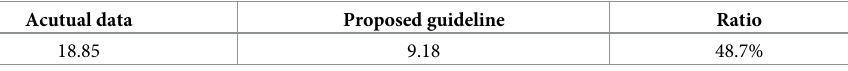
Table 9. Comparison of sales